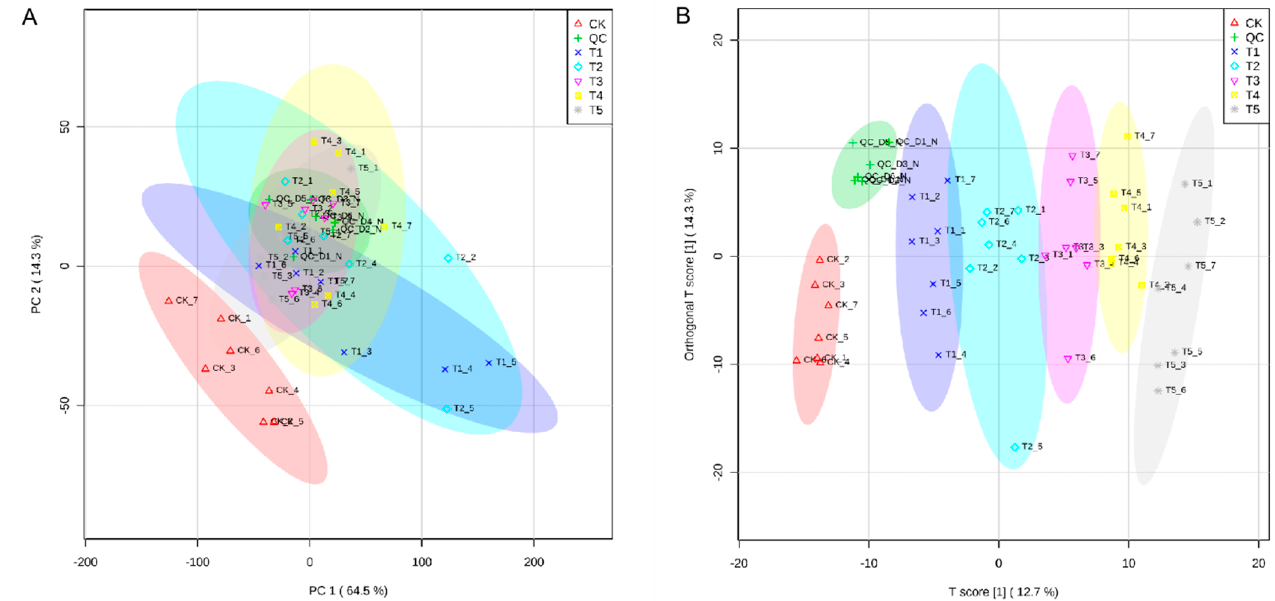
Figure 2. PCA and OPLS-DA of T. laevis -infected and control grains. ( A ) PCA of grains during different fungal hyphal growth. ( B ) Orthogonal partial least squares discrimination analysis (OPLS- DA) (Q = 0.938). CK stands for control, QC stands for quality control, T1 stands for suspension of teliospores, T2 stands for promycelia, T3 stands for primary basidiospores, T4 stands for H-bodies, and T5 stands for secondary basidiospores.